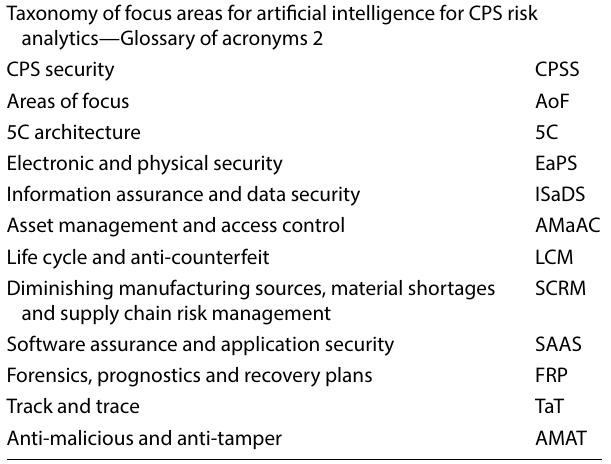
Table 1 Taxonomy of areas of focus (AoF) for cognitive feedback mechanism in predictive cyber risk analytics Taxonomy of focus areas for artificial intelligence for CPS risk analytics—Glossary of acronyms 2